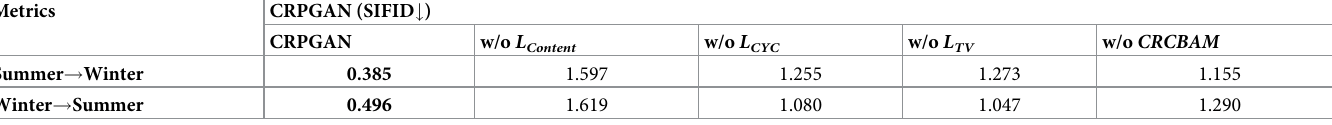
Table 5. Quantitative comparisons results for CRPGAN ablations study in terms of SIFID. The best scores are in bold.